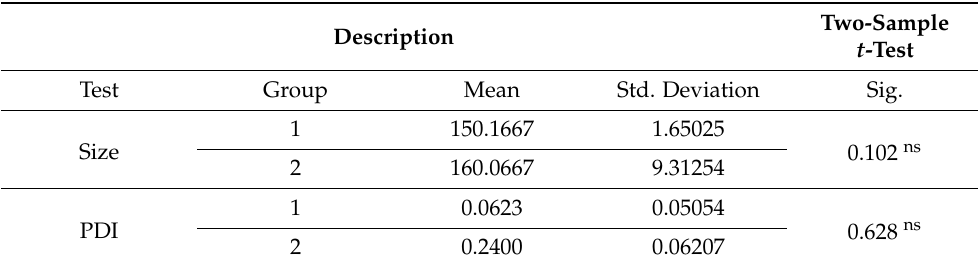
Table 2. Effect of lyophilization process on characterization of PEGylated nanophytosomes loaded with 6-gingerol molecules.